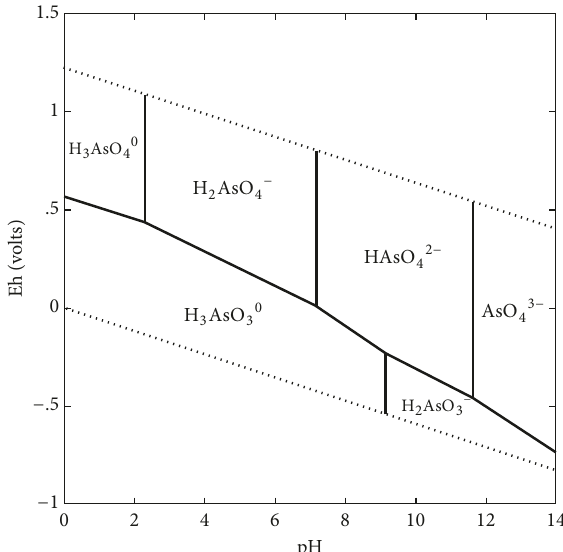
Figure 1: Eh-pH diagram for arsenic species under H-O-As system at 1 bar and 25 ∘